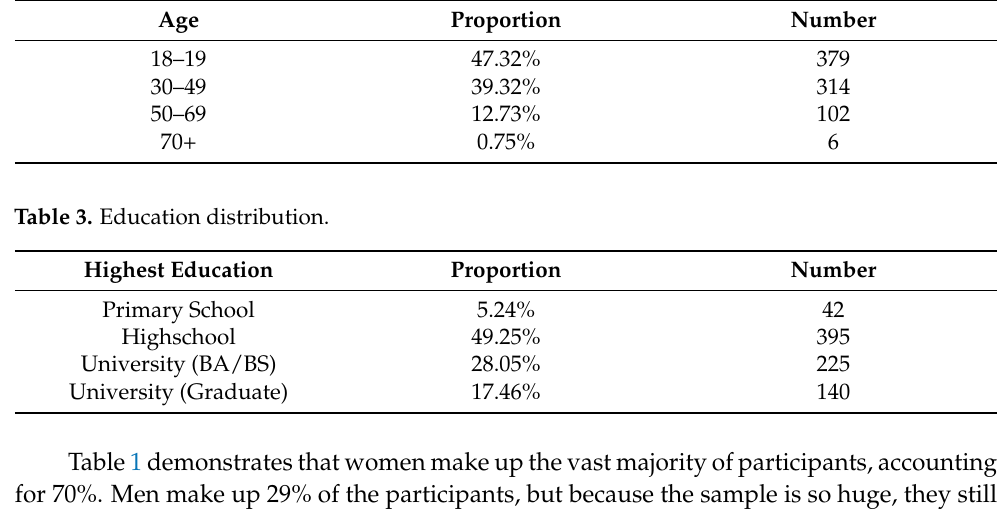
Table 2. Age distribution.